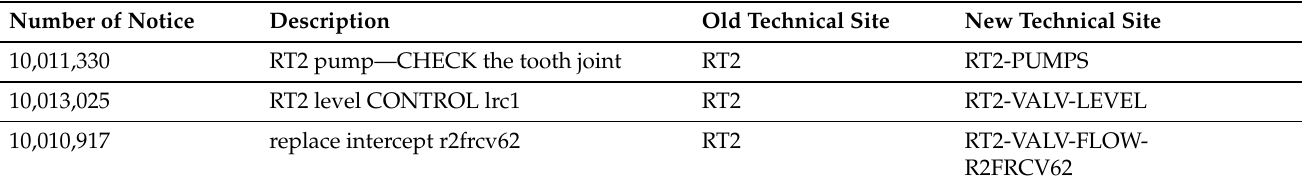
Table 4. Example of reconstruction site using the fourth methodology when the technical site contains just the ROOT element.